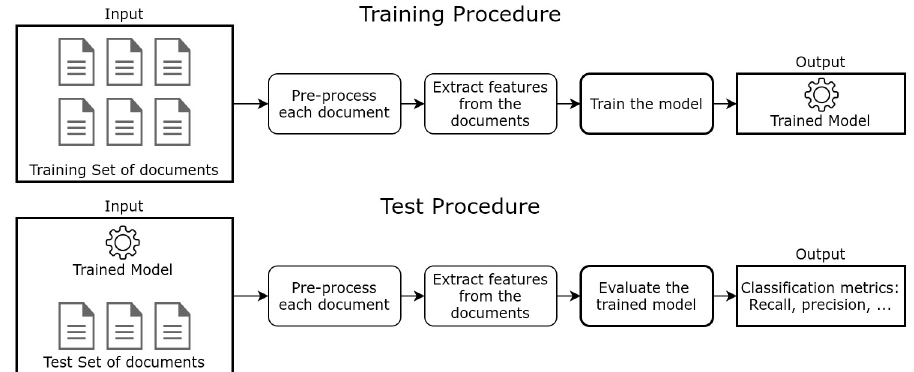
Fig 1. Supervised learning for document